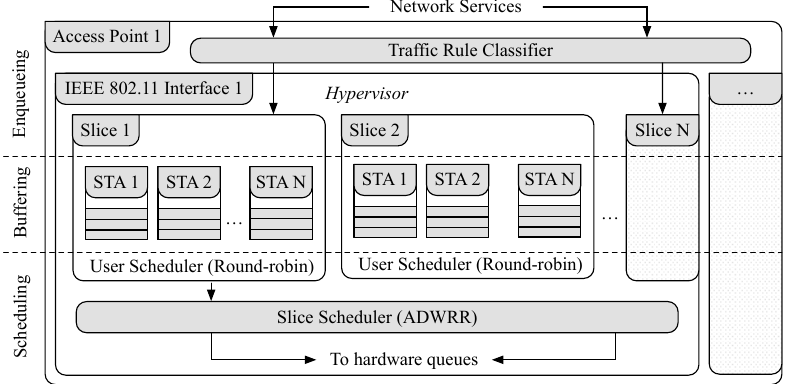
Figure 3. Simplified slice queue structure and data traffic flow in an Access Point